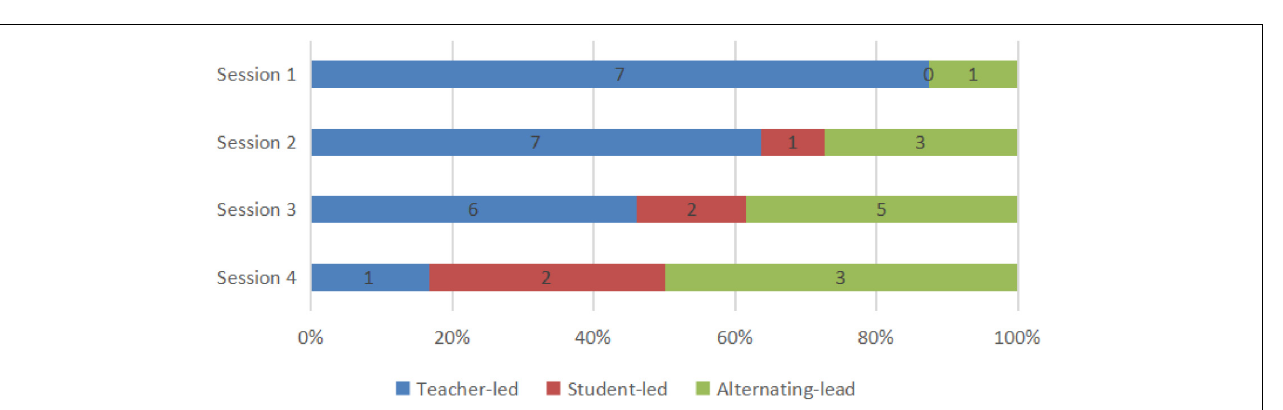
FIGURE 2 | The sum of time periods for discussions of problem solving.